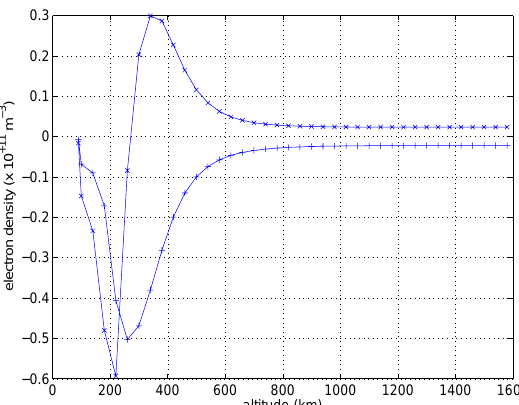
Fig. 4. Vertical basis functions used for the tomographic reconstruc- tions with